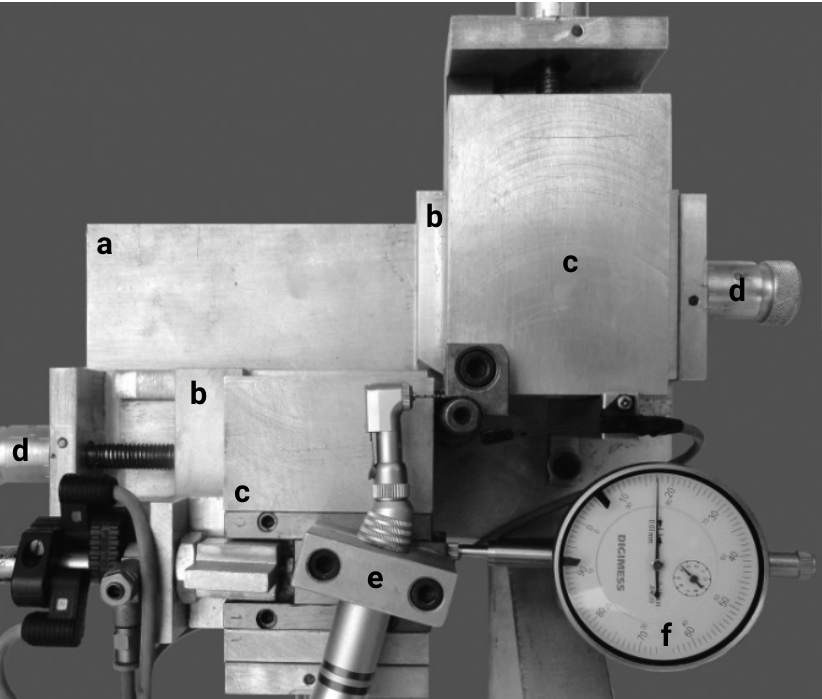
Figure 1. Cyclic fatigue testing apparatus. Letters a , b and c – Rectangular platforms; d – Grading rings; e – Mechanical arm with locking ring to support micromotor/contra-angle/file; f – pneumatic cylinder to reproduce reproducing the pecking